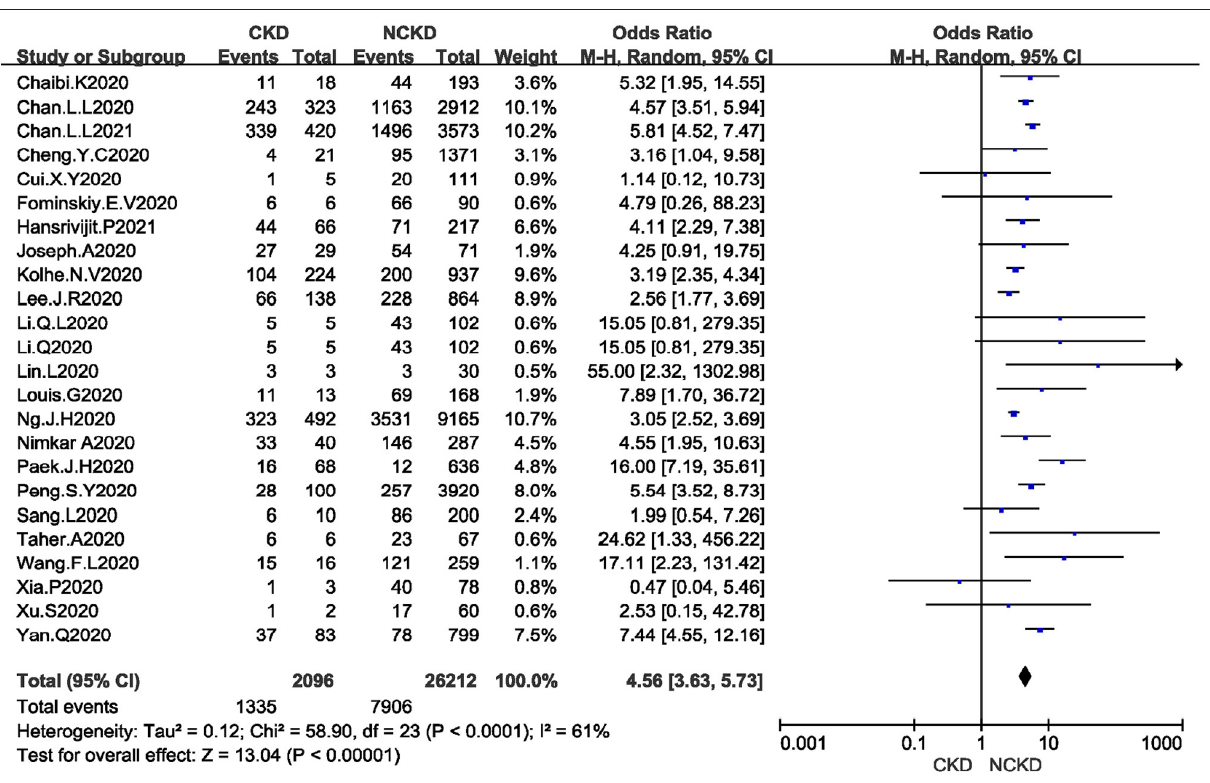
FIGURE 3 | (A) Forest plot showing the relationship between hypertension and AKI in COVID-19 patients. (B) Forest plot showing the relationship between diabetes and AKI in COVID-19 patients. (C) Forest plot showing the relationship between pneumopathy and AKI in COVID-19 patients. (D) Forest plot showing the relationship between cardiovascular disease and AKI in COVID-19 patients. (E) Forest plot showing the relationship between cancer and AKI in COVID-19 patients. (F) Forest plot showing the relationship between CKD and AKI in COVID-19